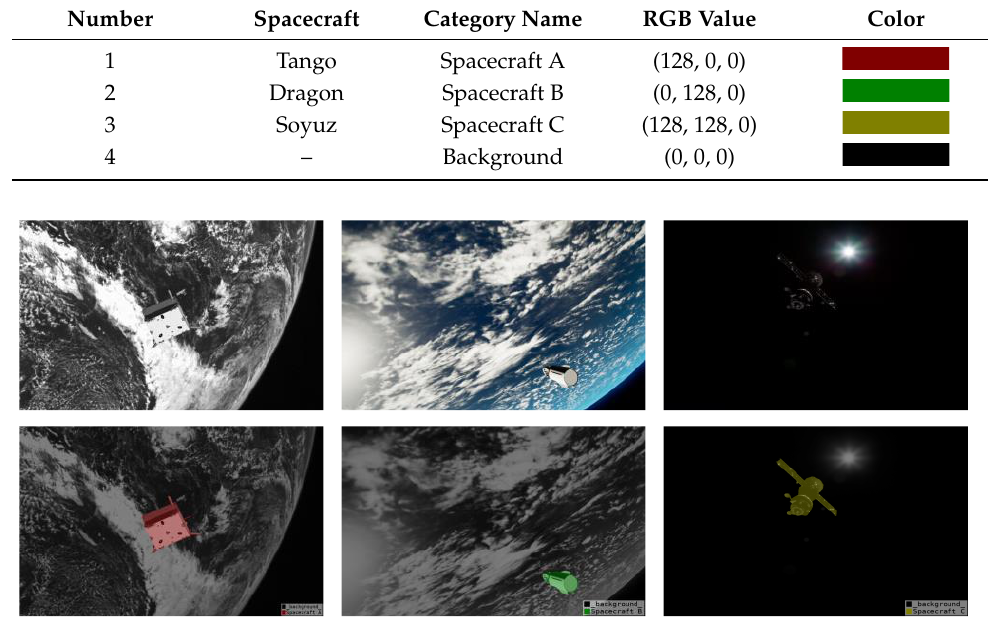
Figure 9. Diagram of the dataset. The first column is the original image, and the second column is the image displayed in an overlapping form after annotation.